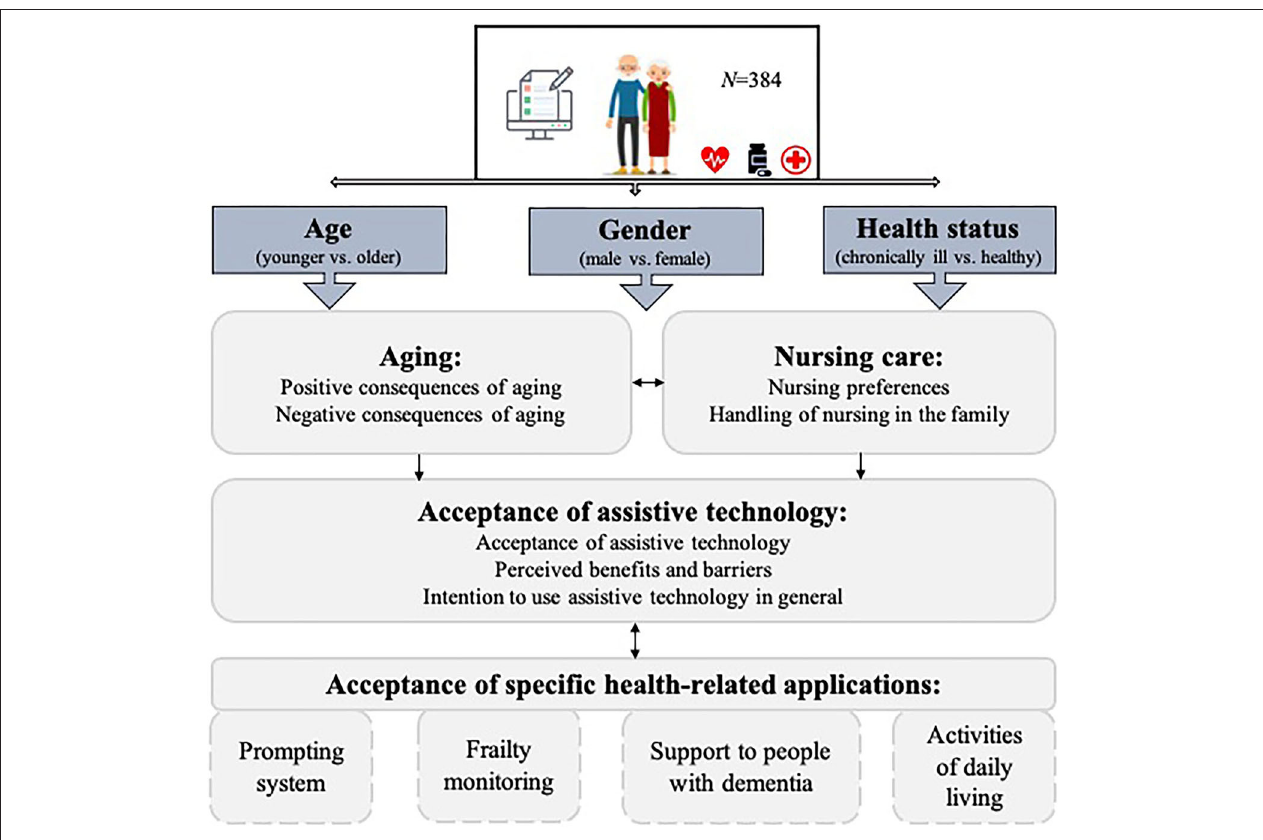
FIGURE 1 | Research design of the